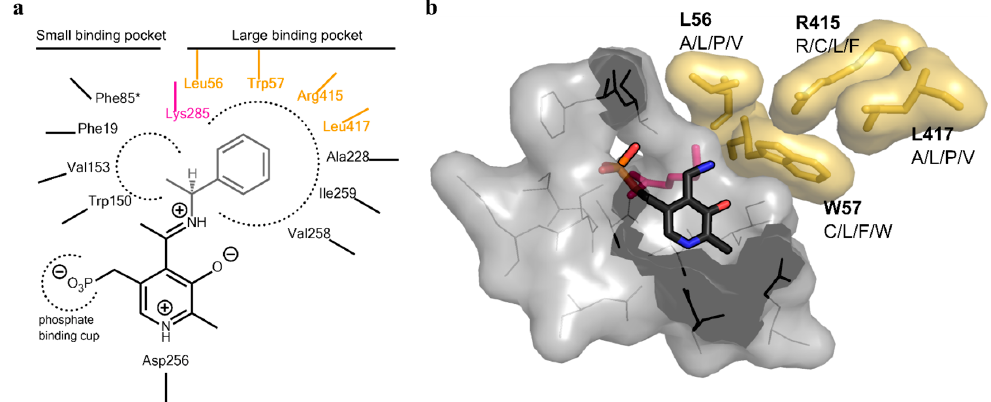
Figure 2. Active site architecture of the ATA from Vibrio fluvialis (PDB code: 4E3Q [5]). ( a ) Schematic drawing of the large and small binding pocket around the external aldimine intermediate (pyridoxal-5 ′ -phosphate (PLP)-Schiff base with ( S )-phenylethylamine). Amino acids covered in the library are highlighted in yellow, the catalytic lysine is highlighted in purple; ( b ) View of the substrate binding pocket. The pyridoxamine-5’-phosphate (PMP) is shown in sticks (dark grey, colored by element). The four residues on which the library was based are displayed together with the amino acid substitutions identified for the mutant library (yellow sticks including van der Waals radius as the surface). The catalytic lysine can be seen in the background behind PMP (purple sticks). The PMP binding pocket is displayed as a light gray surface, including the amino acids shown as lines.